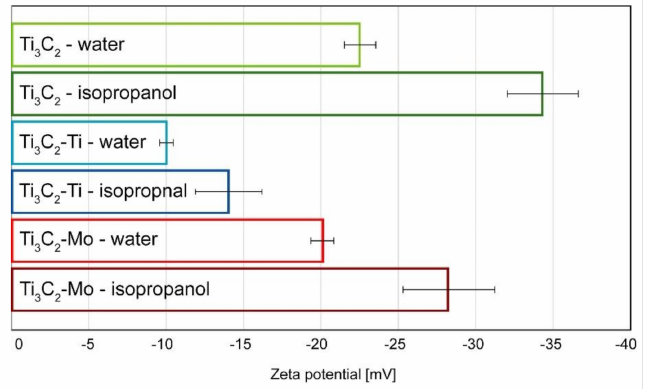
Figure 4. Zeta potential of pristine Ti 3 C 2 , Ti 3 C 2 -Ti and Ti 3 C 2 -Mo in water and in